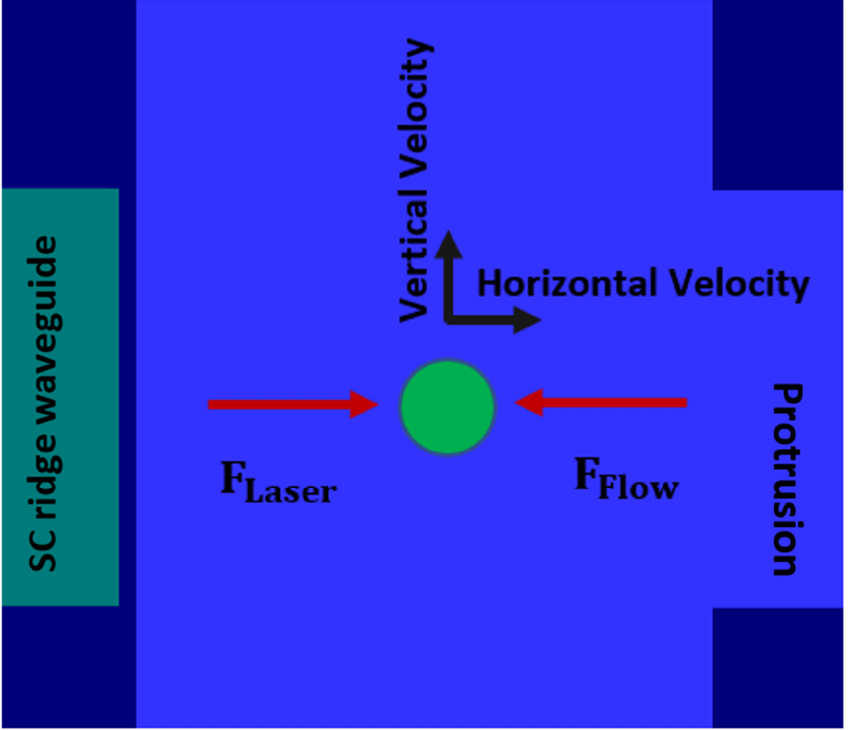
Figure 10 . Forces acting on a particle in the optofluidic section of the device. Minimum laser force needed to trap a particle in the protrusion cavity.